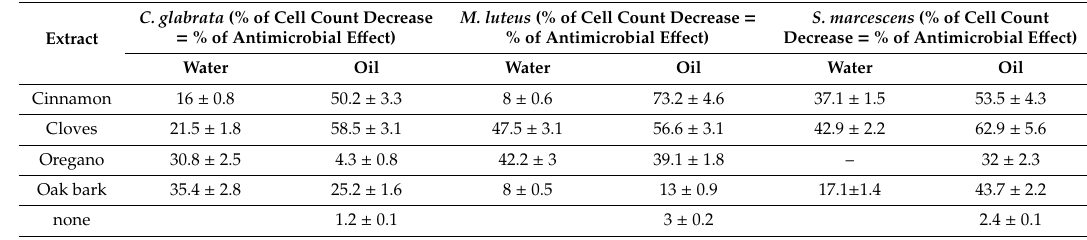
Table 6. Antimicrobial e ff ect of functionalized fibers.